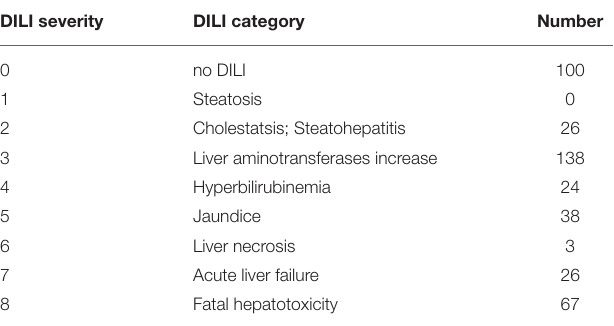
TABLE 1 | Number of objects in DILI2 classes.